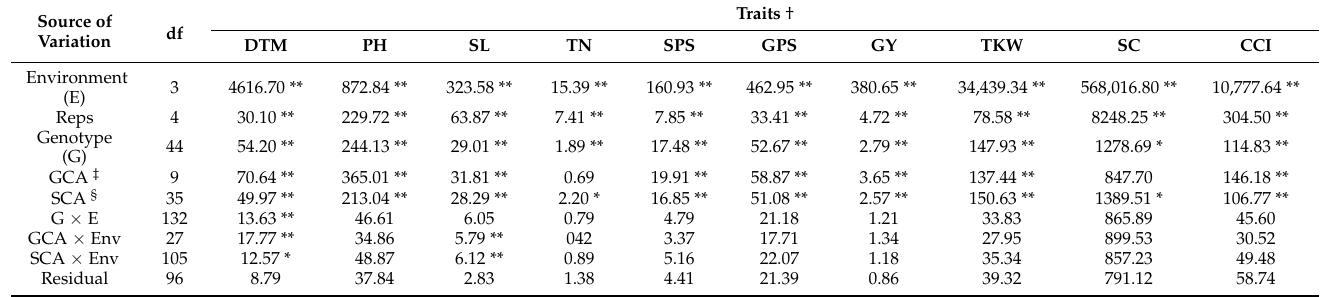
Table 2. Mean squares and significant tests for GCA and SCA effects for assessed agronomic and physiological traits † among 10 wheat parents and their progenies across four